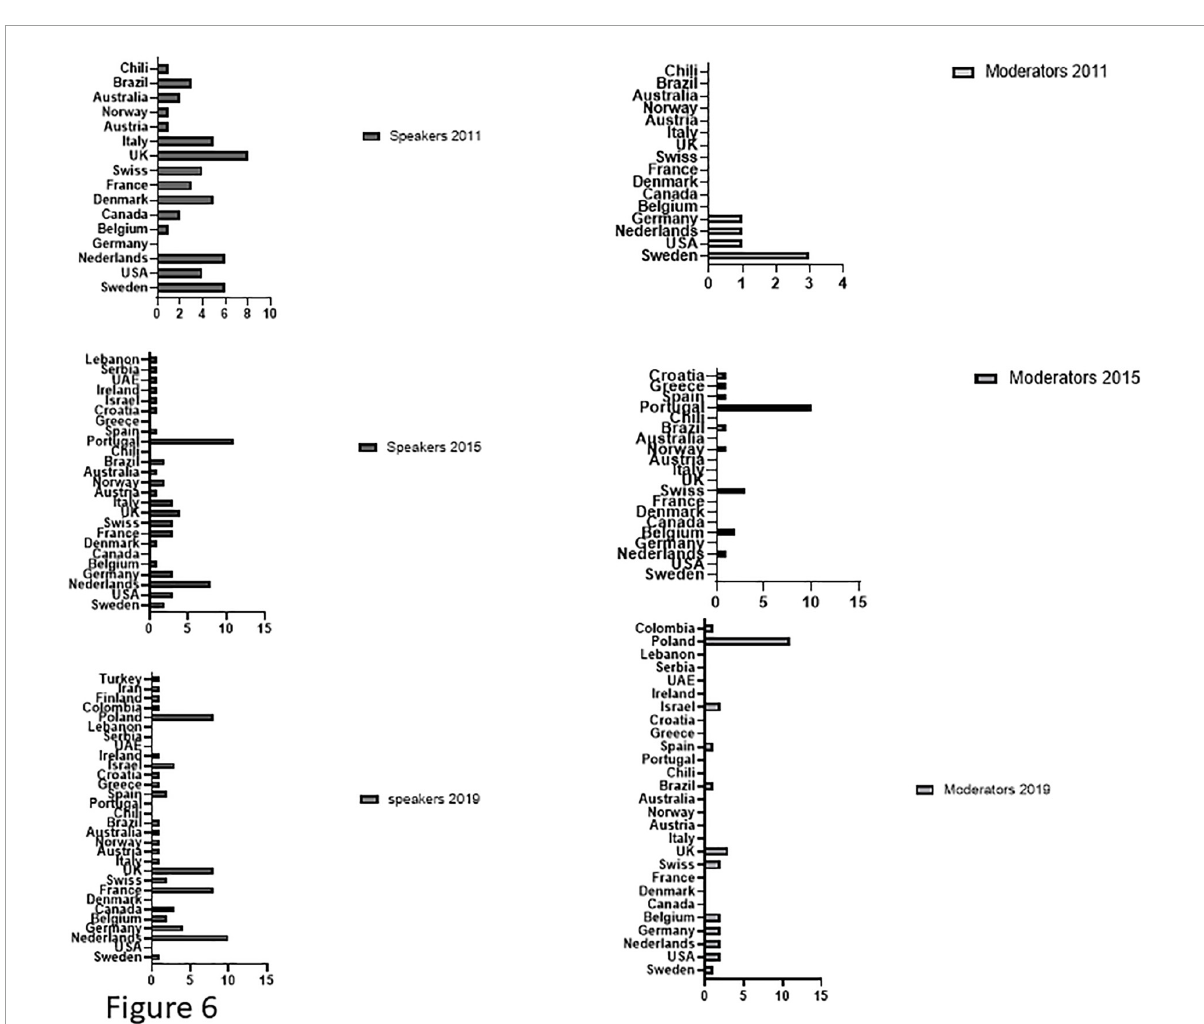
FIGURE6 Countries of origin. Distribution of women participants (moderators and speakers) by country of origin for each of the 3 congresses. Variables are presented as absolute